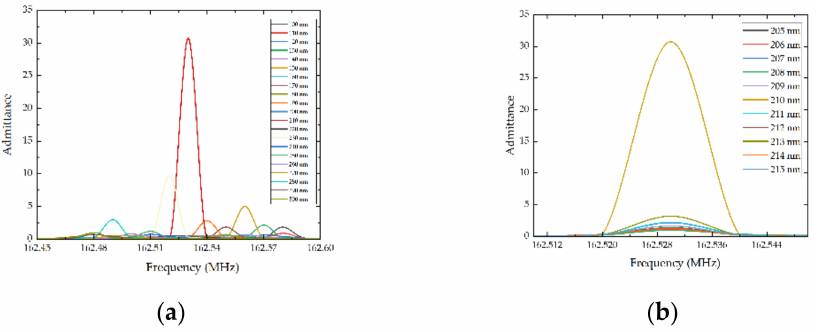
Figure 3. Admittance curves with different thickness of electrodes. ( a ) The thickness of electrodes ranging from 100 nm to 300 nm, ( b ) the thickness of electrodes ranging from 205 nm to 215